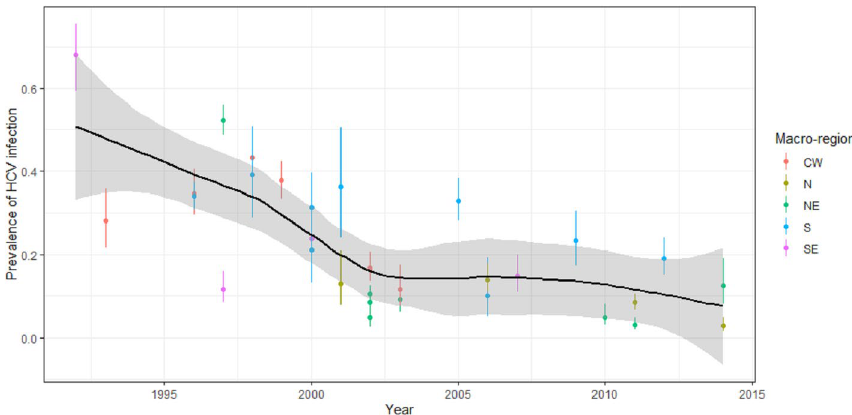
Figure 2. Prevalence rates of HCV infection and 95% credibility intervals in haemodialysis patients in Brazil from 1992 to 2015 according to major geographic region.